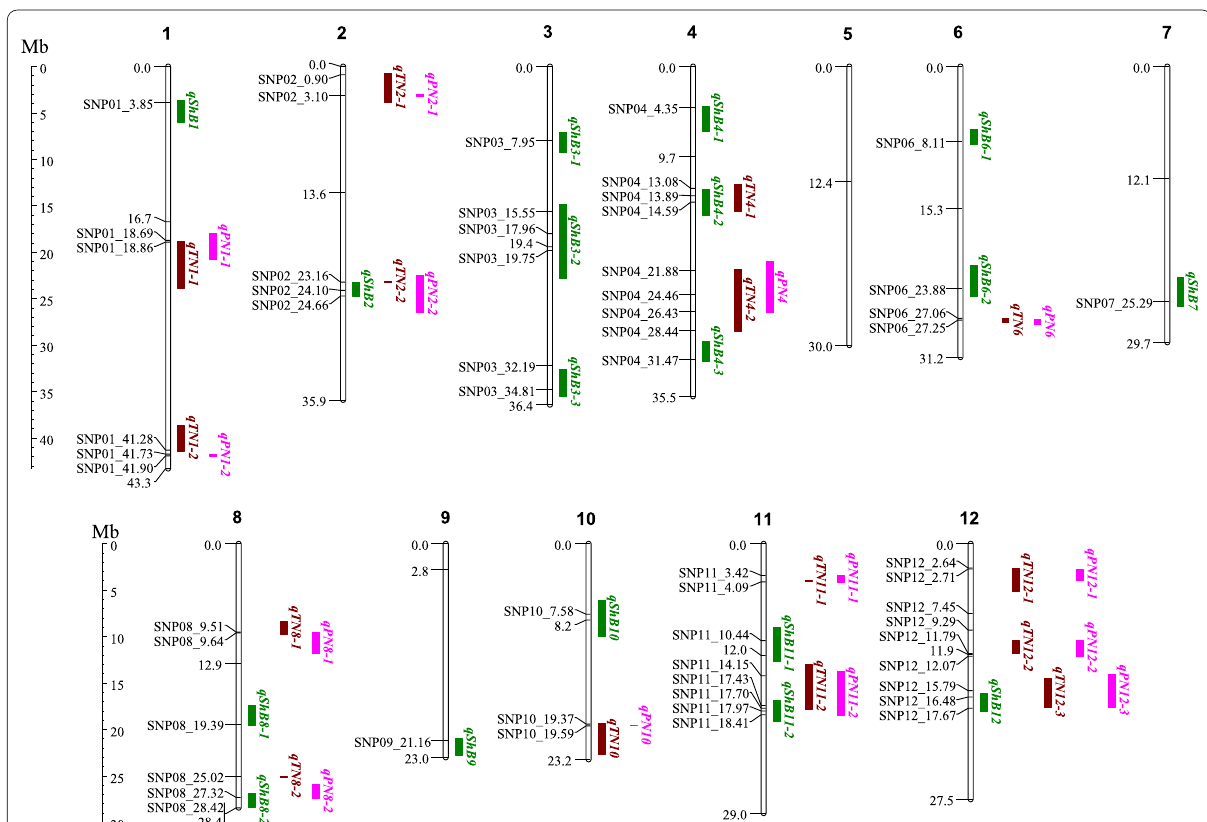
Fig. 2 The physical position of the sheath blight QTL ( qShB ), panicle number QTL ( qPN ) and tiller number QTL ( qTN ) identified by genome-wide association (GWA) mapping in the Rice Diversity Panel-1 (RDP1) with 3,463,224 SNP markers across the entire rice genome. The 21 SNPs ascertaining the 18 ShB- QTL, 18 SNPs defining the 14 PN -QTL and 19 SNPs delineating the 15 TN -QTL are identified by “SNP”, chromosome and megabase (Mb) position based on the Os-Nipponbare-Reference-IRGSP-1.0 assembly (Kawahara et al. 2013). The Mb position of the centromere, and the beginning and end of each chromosome, is given. The details of the ShB-QTL and distinguishing SNPs are in Table 3, PN -QTL and TN -QTL in Table 4, and the QTL are combined in Table S5. [The figure was created with MapChart 2.32 (Voorrips